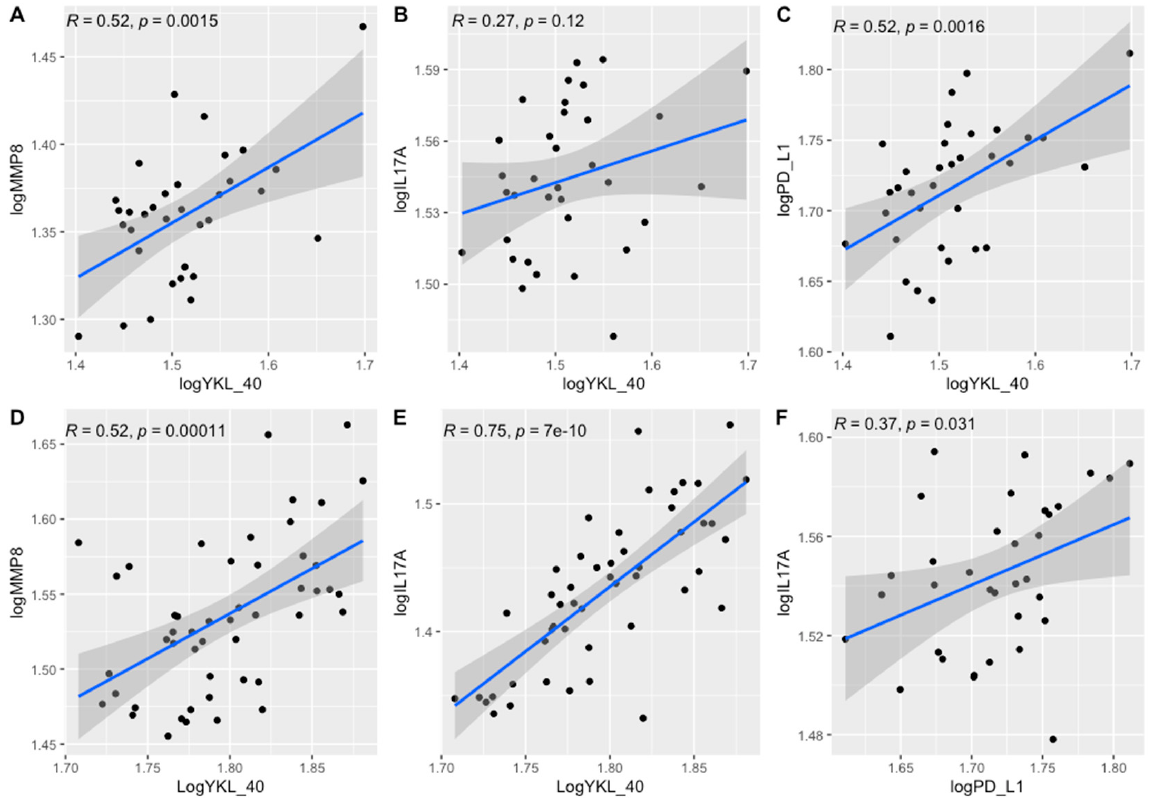
Figure 1. Correlations between the expression of YKL-40, MMP8, PD-L1, and IL17A in GEO datasets GDS4382 ( A – C , F ) and GDS4515 ( D , E ).